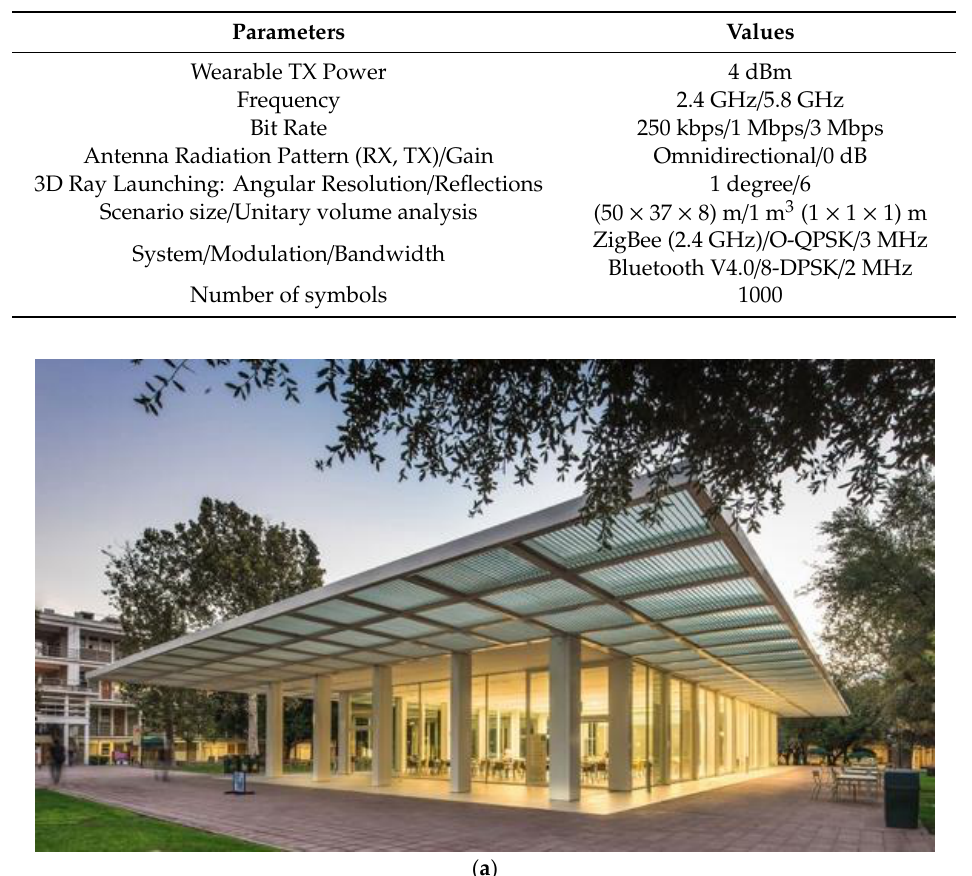
Table 1. Simulation parameters.